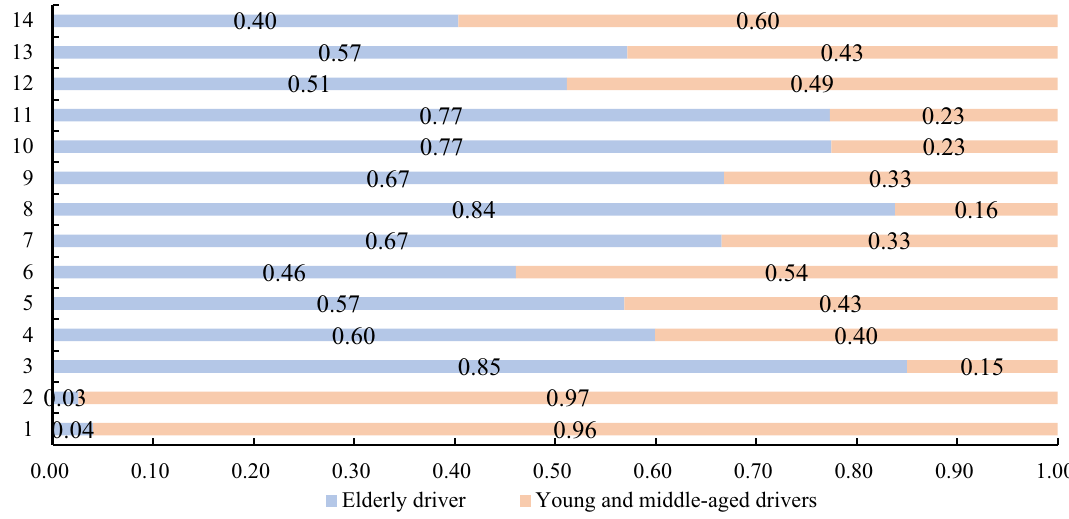
Figure 13. Effect score of the RTCRWS for elderly and middle-aged and young drivers.